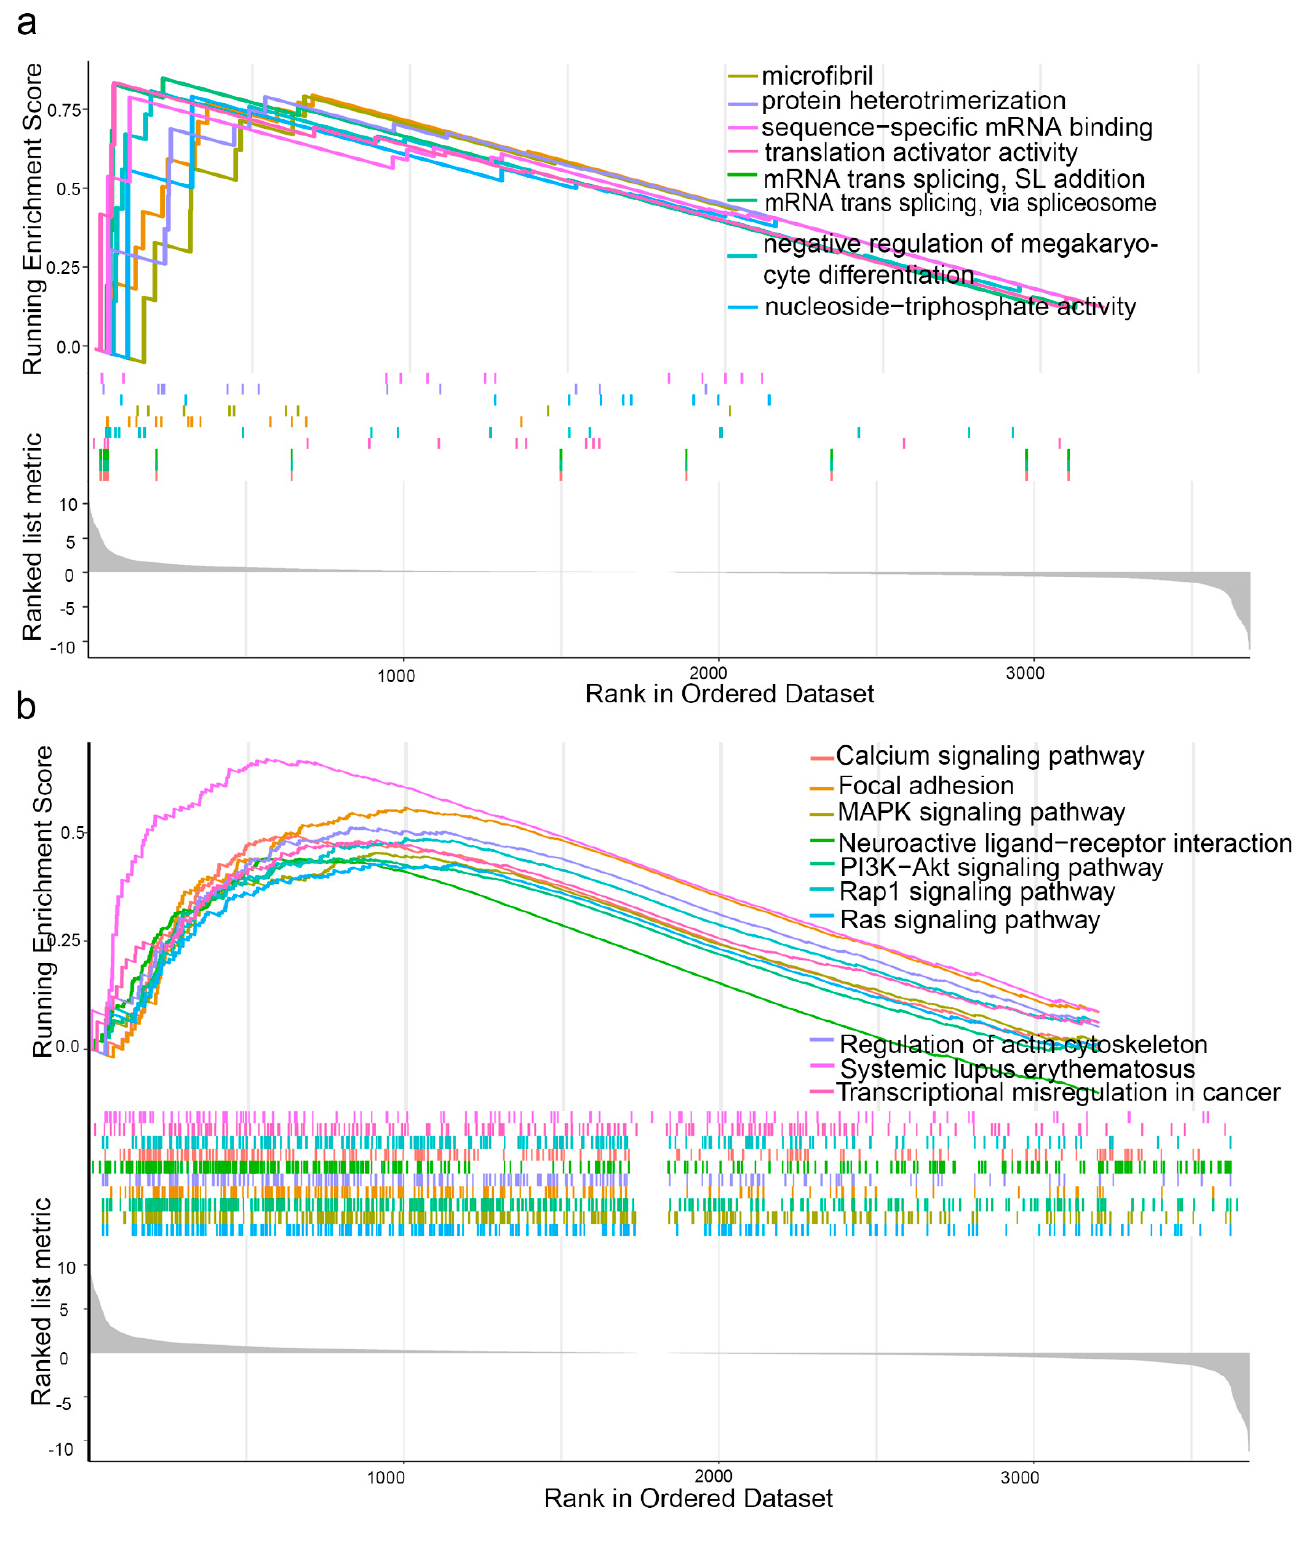
Figure 4. ( a ) Gene ontology gene set enrichment analysis; ( b ) Kyoto Encyclopedia of Genes and Genomes gene set enrichment analysis.